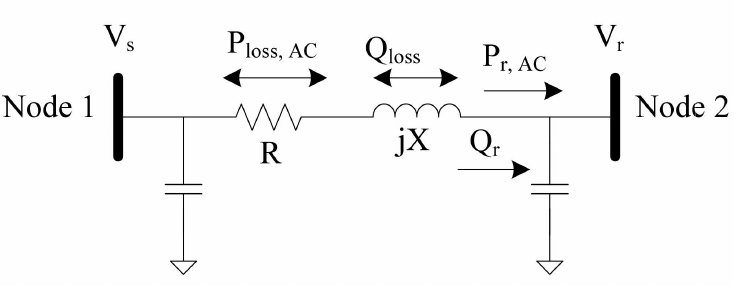
Figure 1. Transmission line